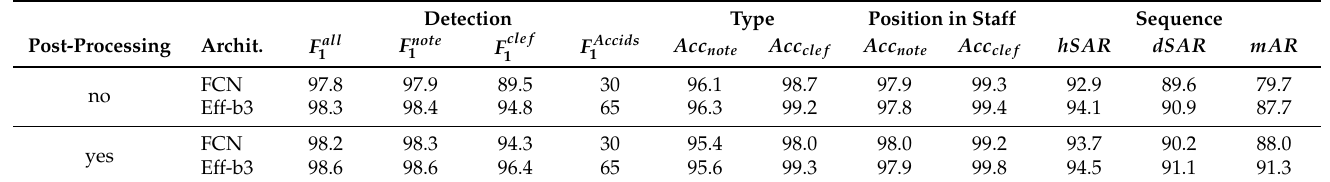
(b) With document specific training without a pretrained model: Using solely the Pa904 dataset for training and evaluation in a 5-fold cross validation similar to experiment 1. Here 4 architectures (FCN, U-Net, Eff-b3, Eff-b7; Table 6) are compared; (c) With a mixed model without fine-tuning: Using the mixed model of experiment 1 and evaluation of the 20 pages of the dataset Pa904 (Table 7). Table 5. Experiments on the Nevers dataset, which was used for evaluation in [12]. Using the post- processing pipeline, the dSAR has improved by about 1%. The melody accuracy rate has improved by 8%. Using more advanced encoders, the mAR could further be improved by about 3%. Detection Type Position in Staff Sequence